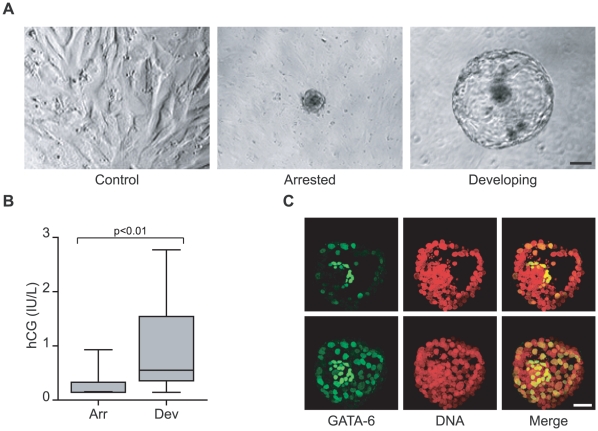
Human embryo development in co-culture.(A) Phase contrast images of decidualizing ESCs alone (control; left) or in the presence of an arrested (middle) or developing human embryo (right) (scale bar  = 100 µm). (B) Arrested embryos (Arr) express significantly less hCG than developing embryos (Dev). Secreted hCG levels were assayed after 72 hours of co-culturing human embryos and decidualizing ESCs (P<0.01). (C) Formation of primitive endoderm in developing human embryos co-cultured with decidual ESCs. Optical cross-sections through a day 8 embryo, cultured first on a decidualizing ESC monolayer for 72 hours, demonstrates the presence of GATA-6 positive cells aligning predominantly to the blastocoelic surface of the inner cell mass, which corresponds to the location of the primitive endoderm (top panel). The lower panel represents z-projection of all the images in the stack from a top to bottom scan through the embryo (scale bar  = 50 µm).